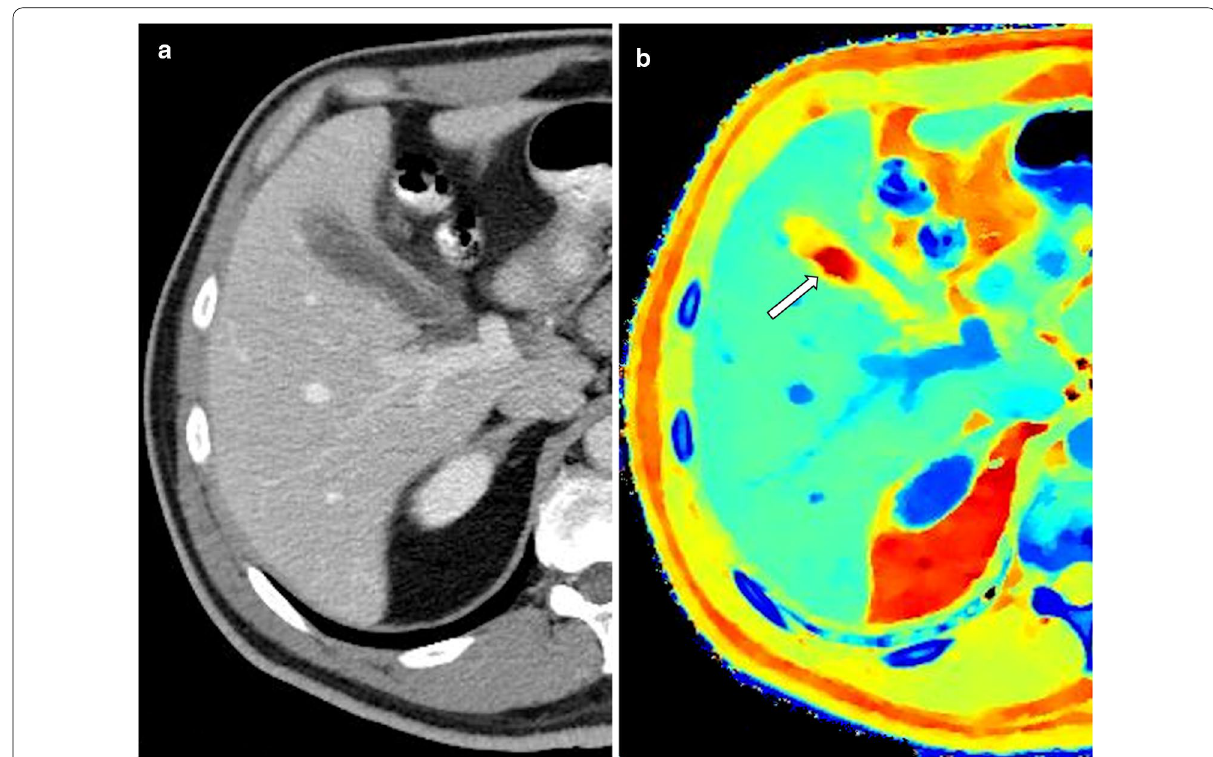
Fig. 7 CT of a 64-year-old man showing mild heterogeneity of the gallbladder contents on conventional images ( a ), with a clear gallbladder stone visible on the effective atomic number map ( b ) as a focal area with lower atomic number than surrounding bile (arrow)